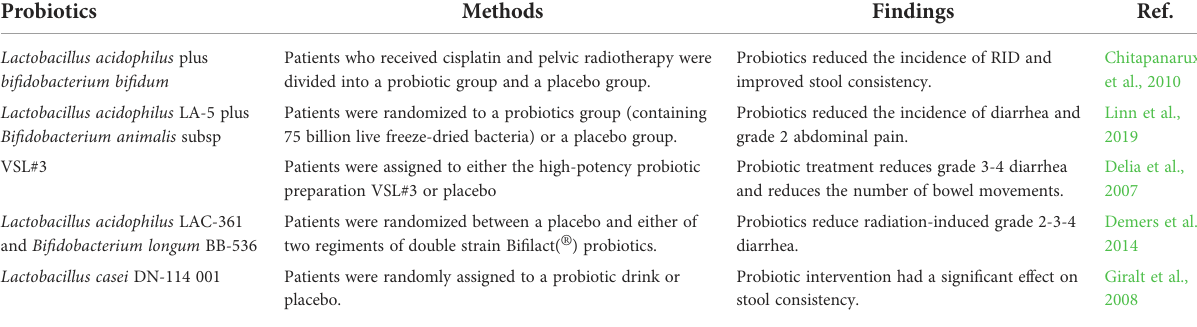
TABLE 2 Studies with the role of probiotics in the prevention of RID therapy for cervical cancer. Probiotics